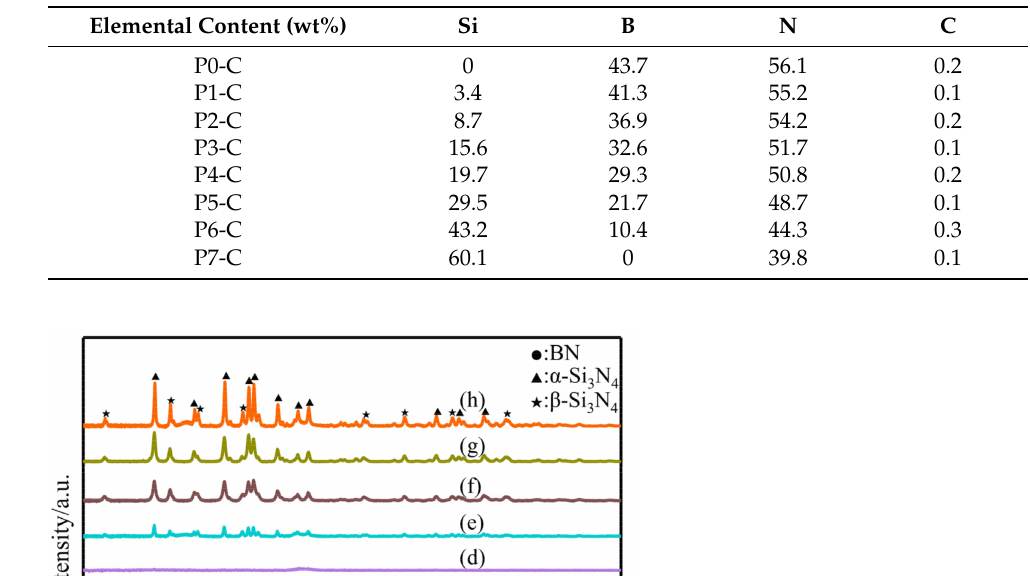
Table 2. Elemental content of different BN/Si 3 N 4 composite ceramics.